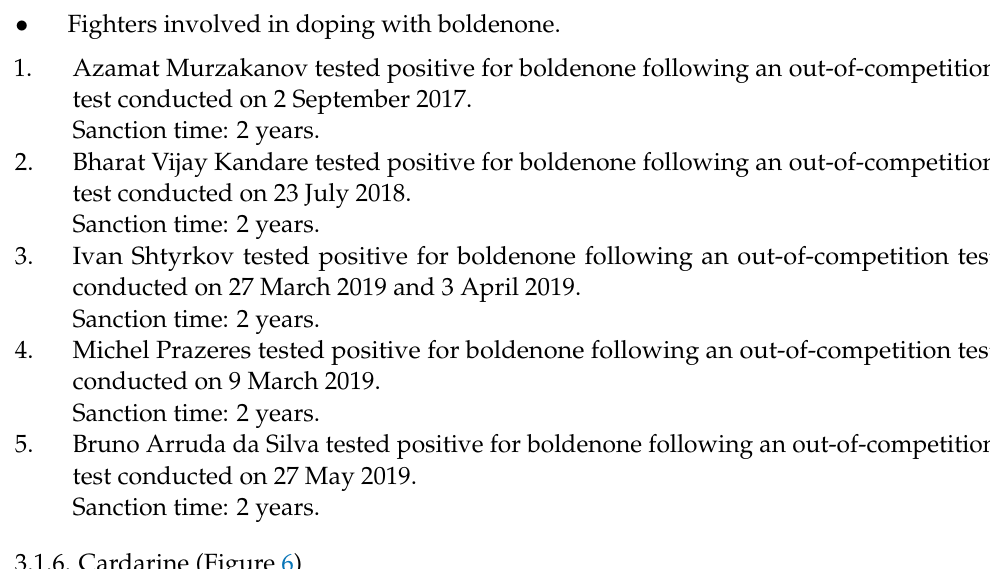
Figure 5. Chemical structure of boldenone. Formula: C 19 H 26 O 2. muscle mass and strength.